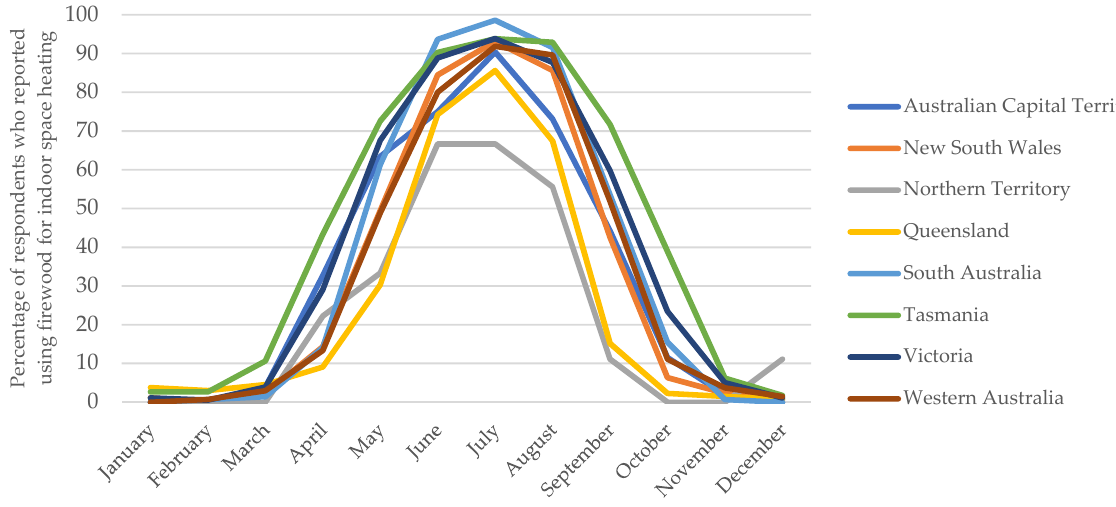
Figure 3. Use of firewood for indoor space heating across different months of the year (n = 936).